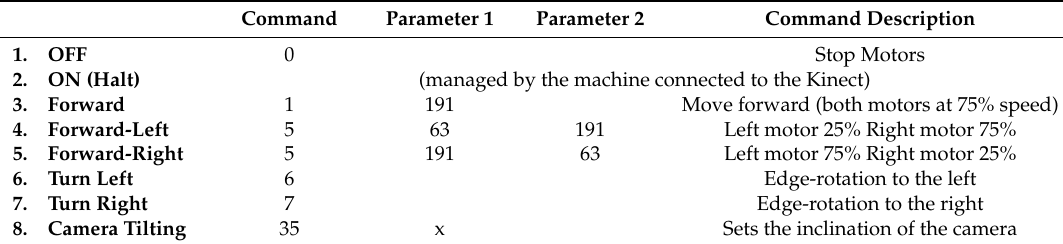
Table 7. Charlie API commands associated with different